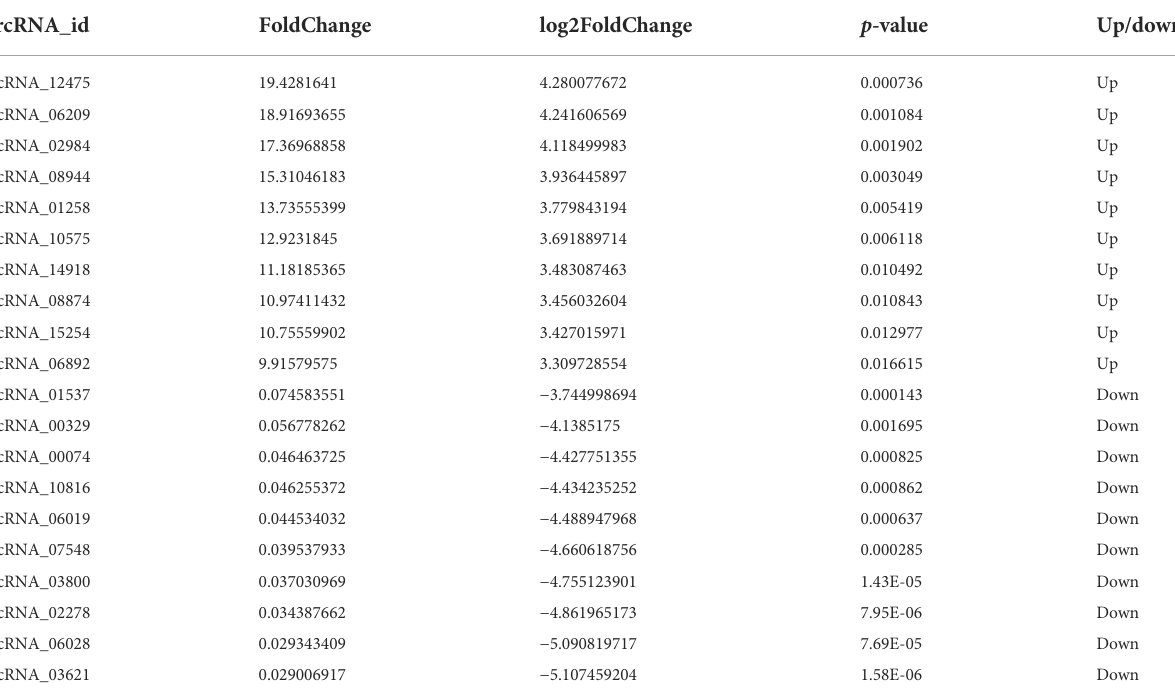
TABLE 2 The top10 DE circRNAs identi fi ed from the iCCA vs. iCCAP. circRNA_id FoldChange log2FoldChange p -value